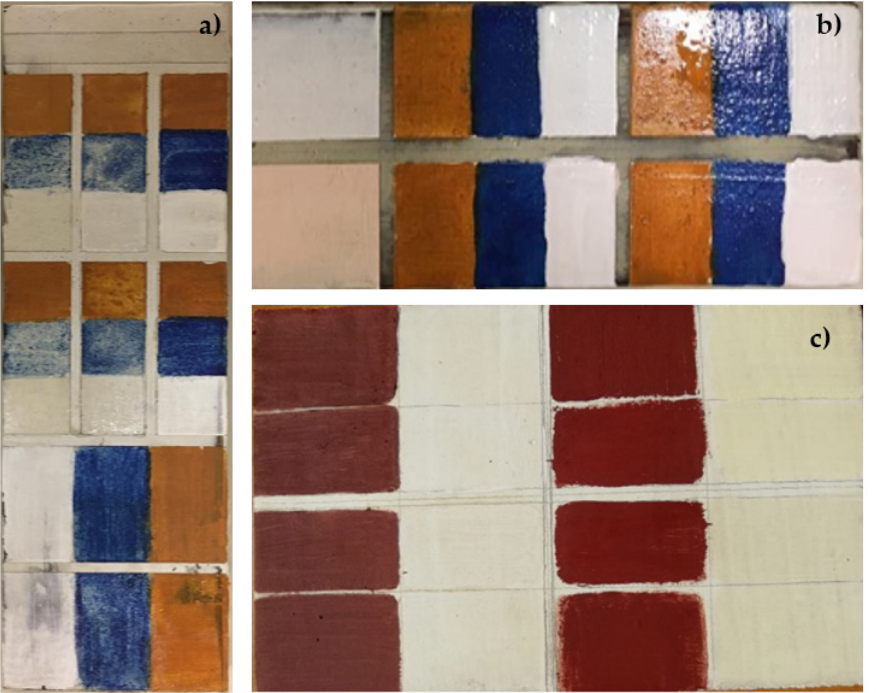
Figure 1. Mock-up samples prepared in the laboratory: painting layers on ( a ) calcite ground layer; ( b ) white and pink priming layers; ( c ) gypsum ground layer. The pigments were lead white, azurite and yellow ochre for ( a ) and ( b ), and lead white and hematite for ( c ).